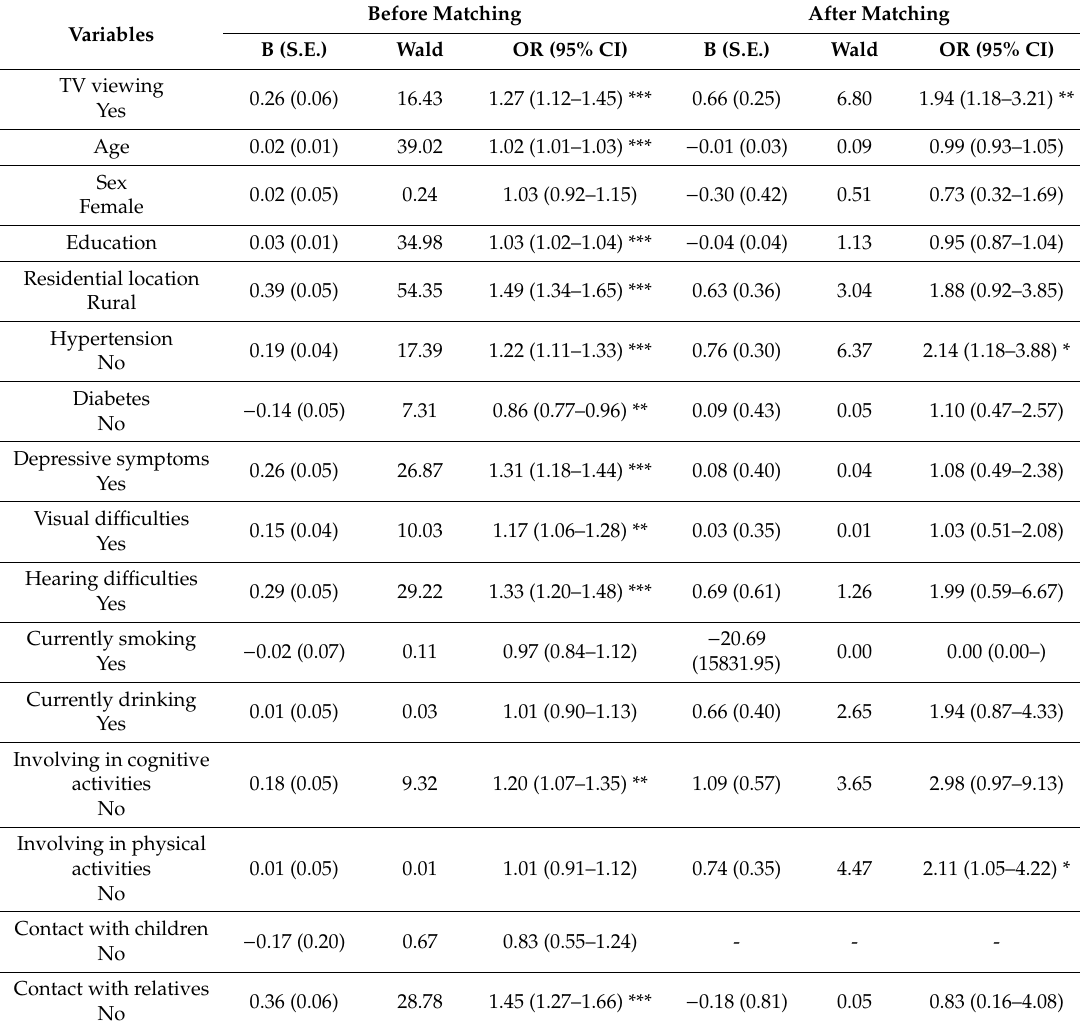
Table 3. Association between TV viewing and cognitive